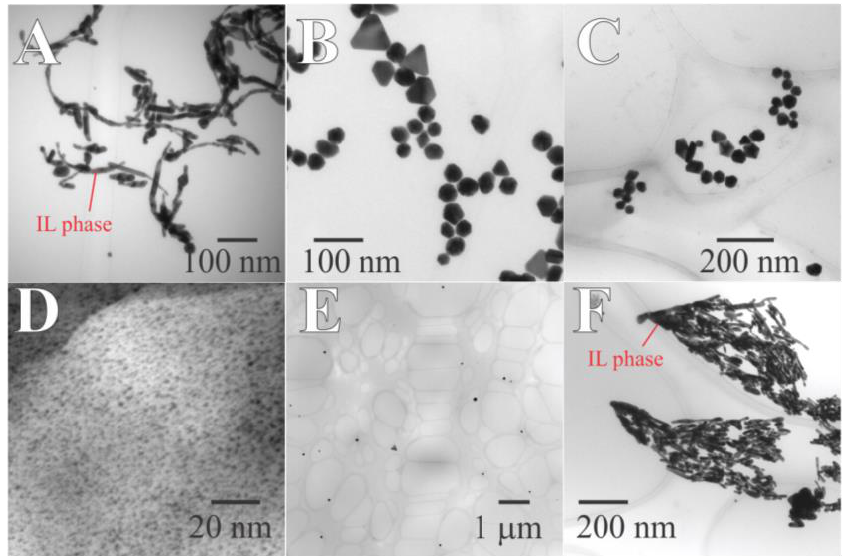
Figure 8. TEM micrographs of samples taken from the aqueous phase after one cyclic voltammetric scan performed at a 25 µm diameter w|DCE ( A – C ) or w|IL ( D – F ) interface at pH 2, 5.5 – 6, and 8.5 for the left-hand, center, and right-hand panels, respectively. [KAuCl 4 ] = 1 mM throughout; however, [FcIL] = 10 ( A ), 5 ( B ), 20 ( D , E ), and 500 mM ( C , F ). ‘IL phase’ indicates residual ionic liquid surrounding the NPs.